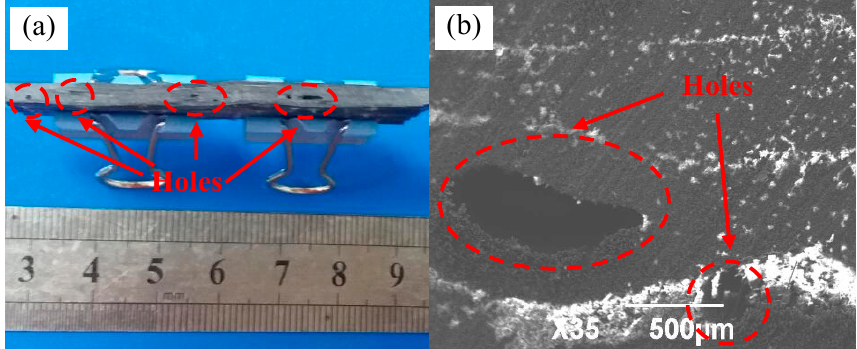
Figure 7. The hole defect of 2D-T700/E44 composite prepared by ICM. ( a ) Macroscopic hole defect; ( b ) Microscopic hole defect.